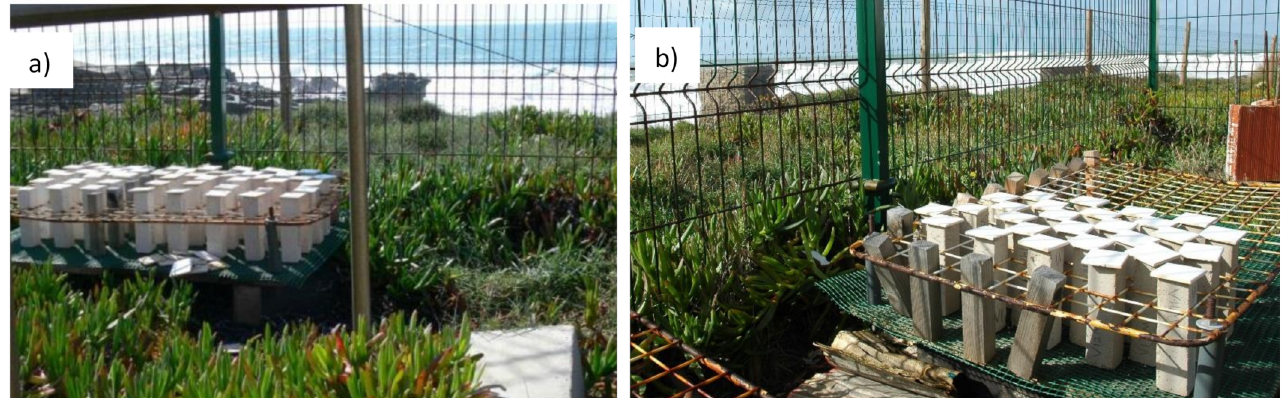
Figure 2. Mortar specimens exposed at LNEC’s Natural Exposure Station in Cabo Raso, Lisbon, seeing organization and the Atlantic Ocean ( a , b